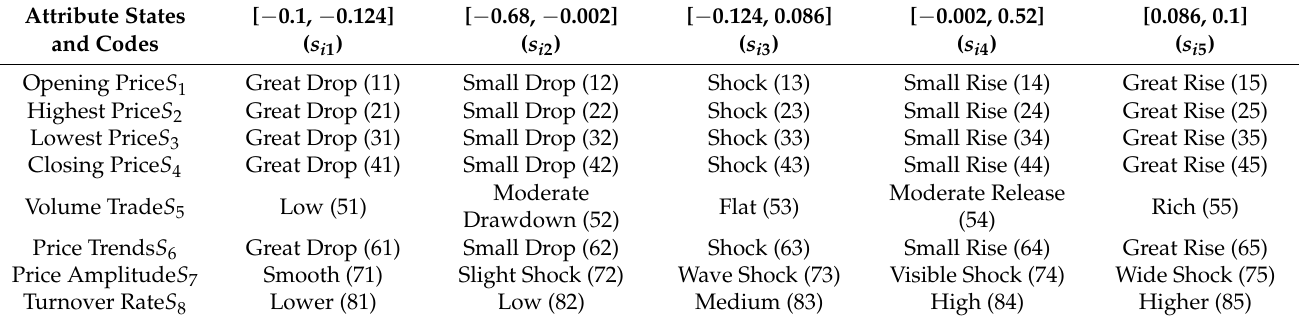
Table 1. The fuzzy intervals and corresponding codes of the attribute